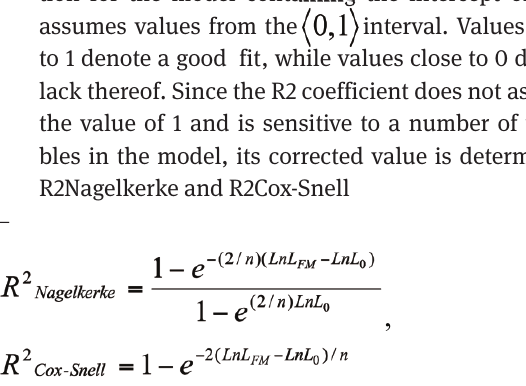
Table 2: The matrix of case classifications.